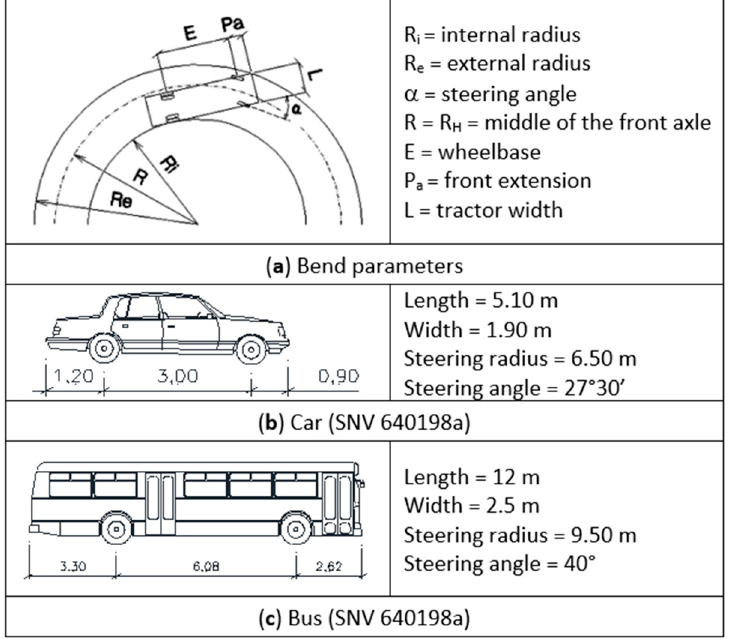
Figure 1. Bend parameters and car and bus dimensions [9].